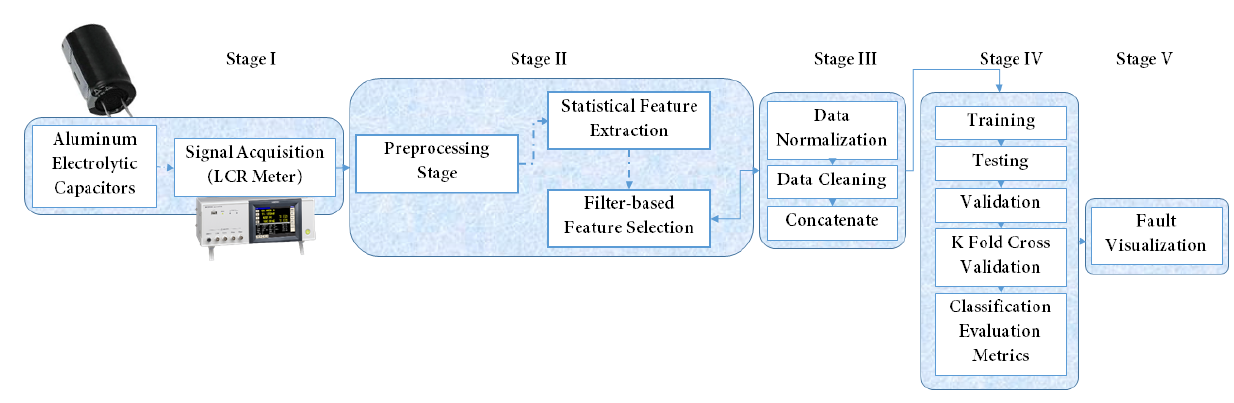
Figure 3. A detailed step by step supervised learning framework for